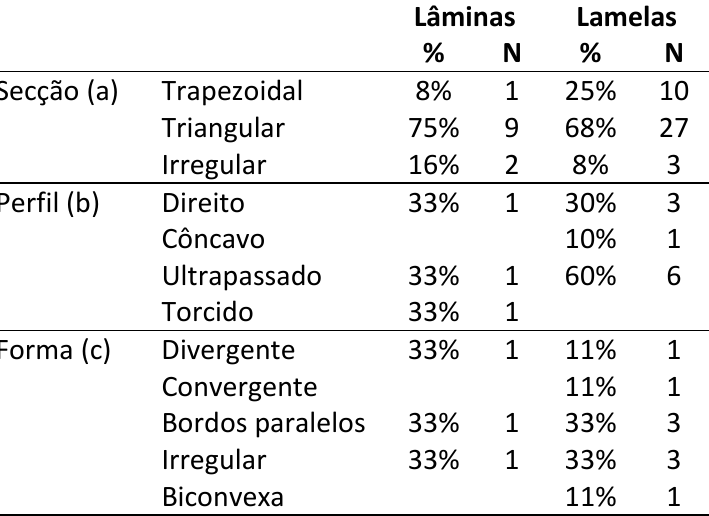
Apenas peças inteiras. (c) Peças inteiras e mesiais Table 4. General attributes of the blade or bladelet knapping in flint from Test 3. (a) Complete and broken artifacts. (b) Only Complete artifacts. (c) Complete and mesial